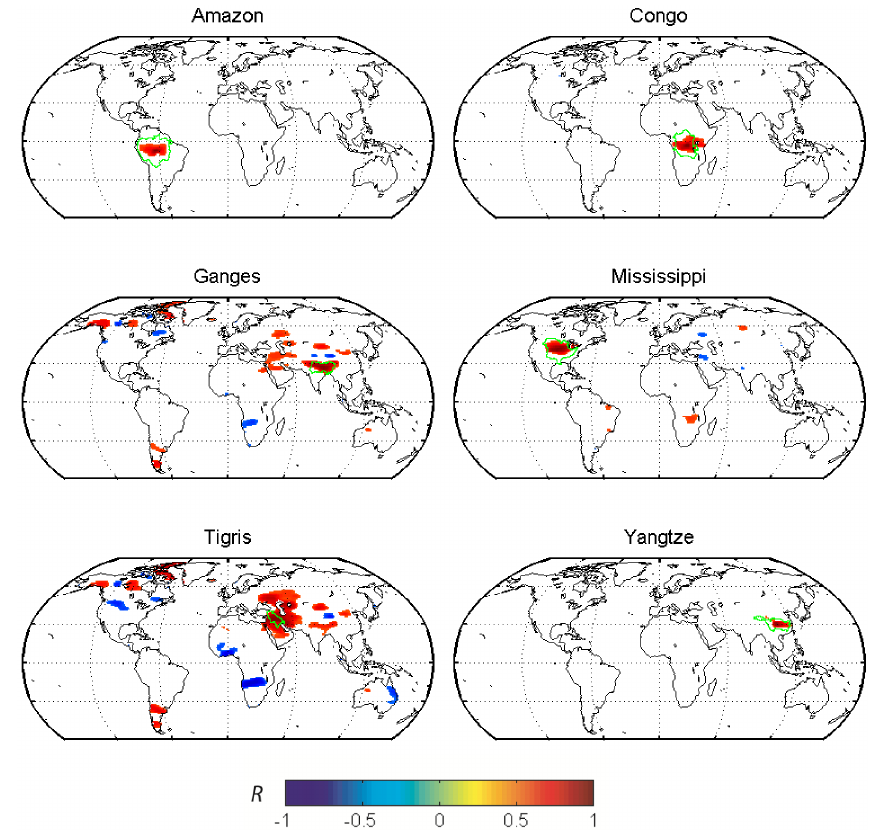
Figure 3. GRACE connection patterns after cutoff threshold τ = 0.57 is applied (the green solid line delineates basin